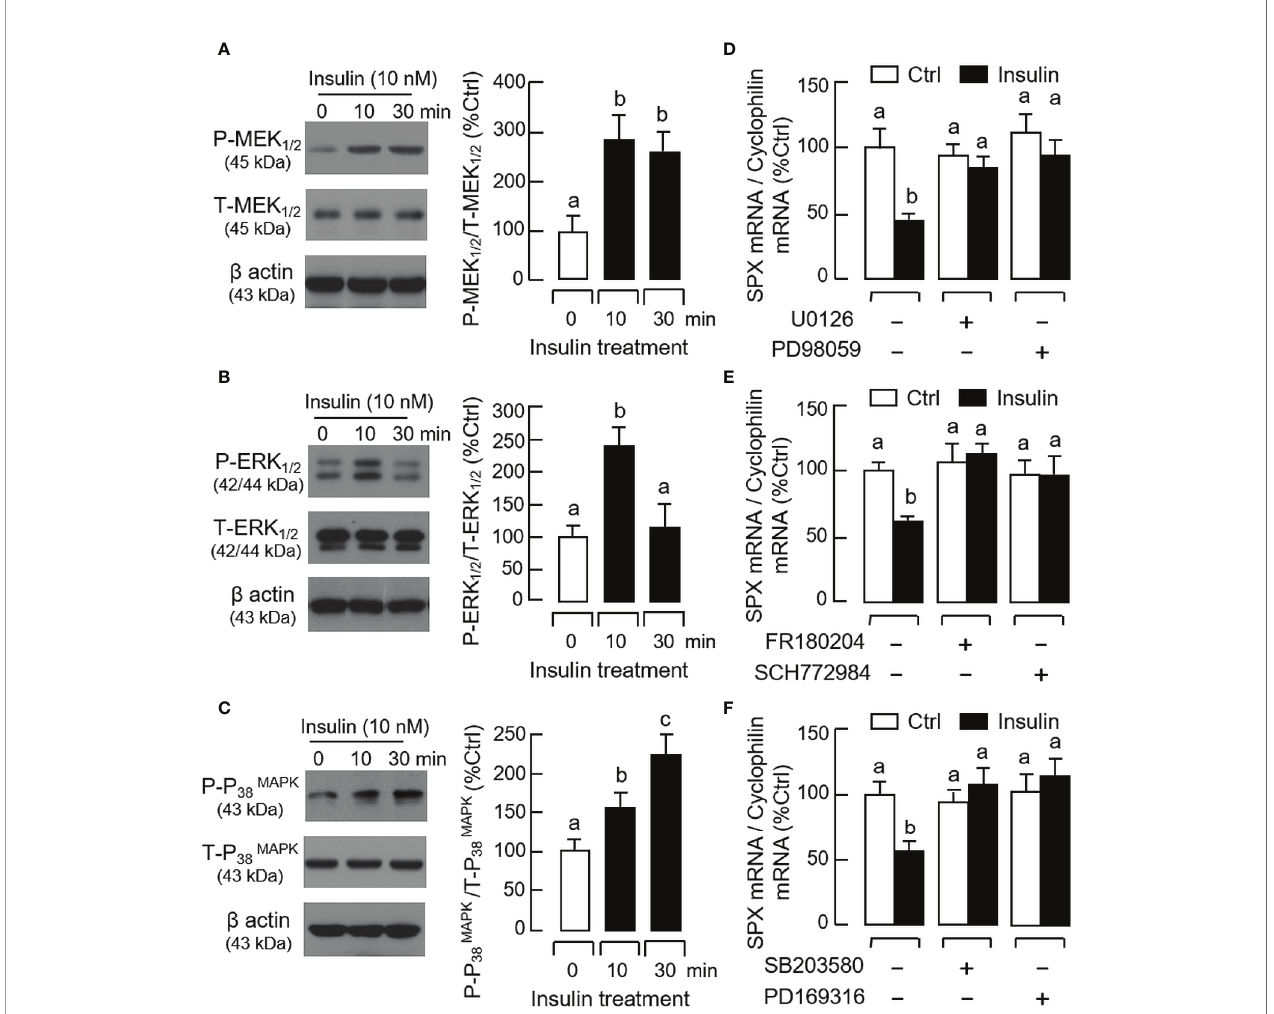
FIGURE 9 | Functional role of MAPK cascades in insulin inhibition of SPX gene expression in mouse gastric mucosal cells. Insulin treatment (10 nM) up to 30 min on (A) MEK 1/2 , (B) ERK 1/2 , and (C) P 38 MAPK phosphorylation in gastric mucosal cells using Western blot with antibodies for the phosphorylated form ( “ P- ” form) and total protein ( “ T- ” form) of respective targets. Parallel blotting for b actin was used as internal control. Co-treatment with (D) the MEK 1/2 inhibitors U0126 (10 µM) or PD98059 (10 µM), (E) the ERK 1/2 inactivators FR180204 (2 µM) or SCH772984 (10 nM), and (F) the P 38 MAPK blockers SB203580 (10 µM) or PD169316 (10 µM), respectively, on insulin inhibition (10 nM) of SPX mRNA expression in gastric mucosal cells. In these experiments, the duration of drug treatment was fi xed at 24 h. Data presented (mean ± SEM, N = 8) were analyzed by one-way ANOVA followed by Newman-Keuls test and the groups denoted by different letters represent a signi fi cant difference at p <